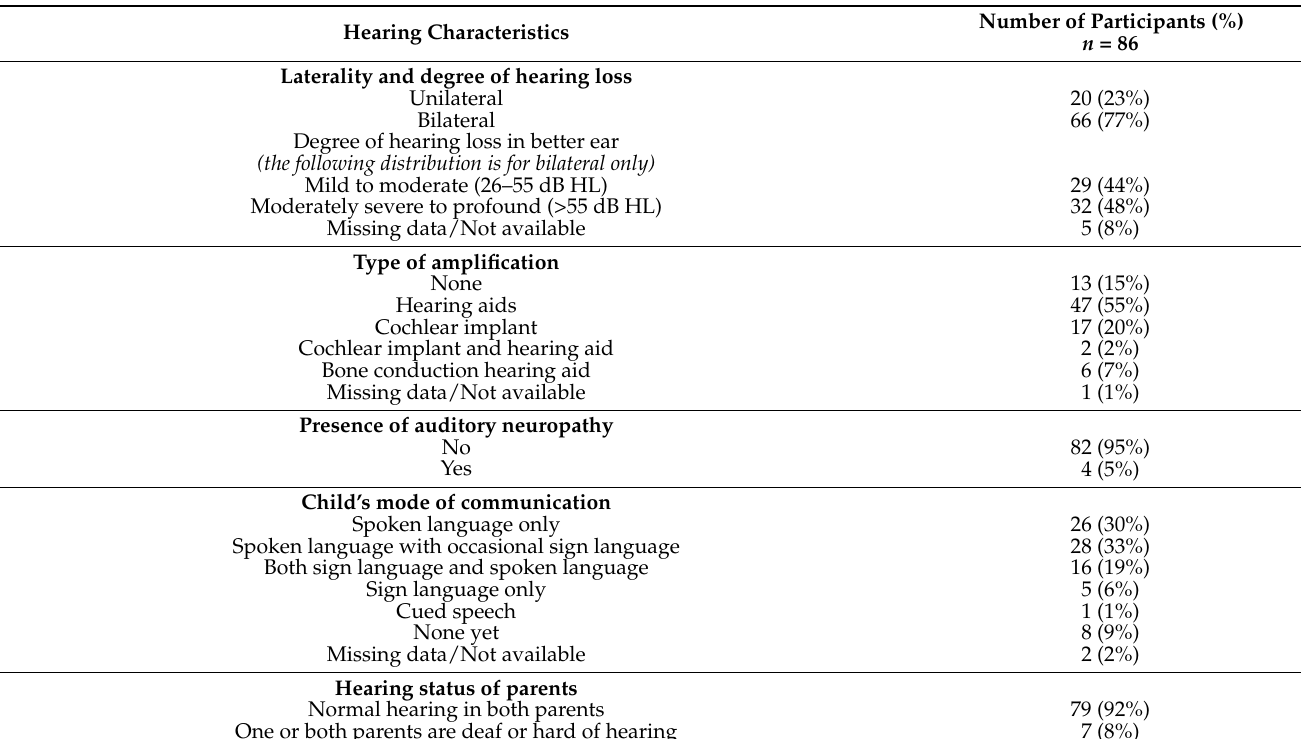
Table 2. Characteristics of hearing loss and age of hearing loss identification, amplification, interven- tion, and communication mode